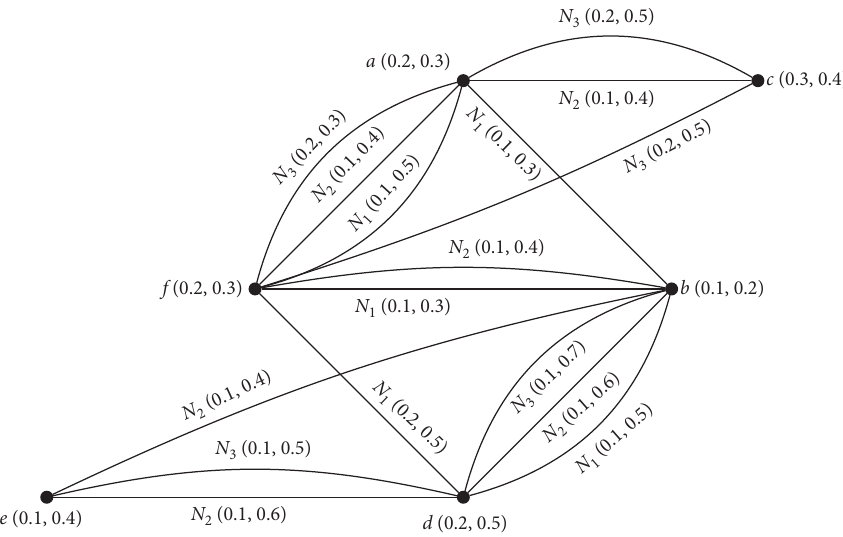
Figure 4: VGS ξ � ( M,N